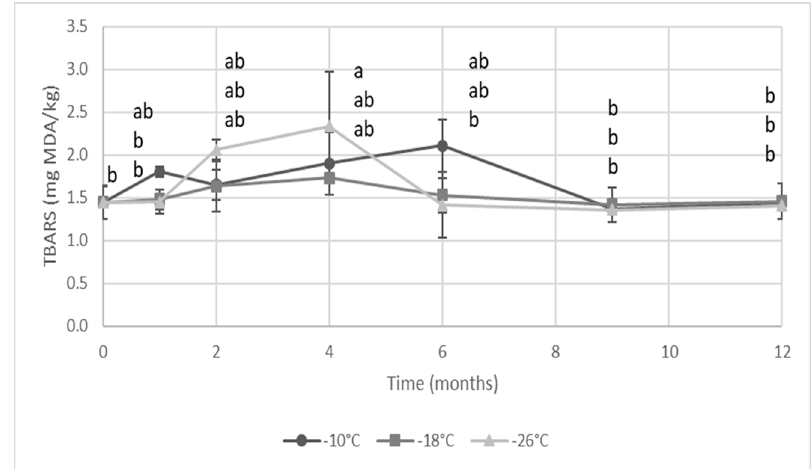
Figure 2. Thiobarbituric acid reactive substances (TBAR) values of mechanically separated mantis shrimp flesh during frozen storage at − 10, − 18 and − 26 °C. Different letters indicate significant differences (at p < 0.05) among samples.